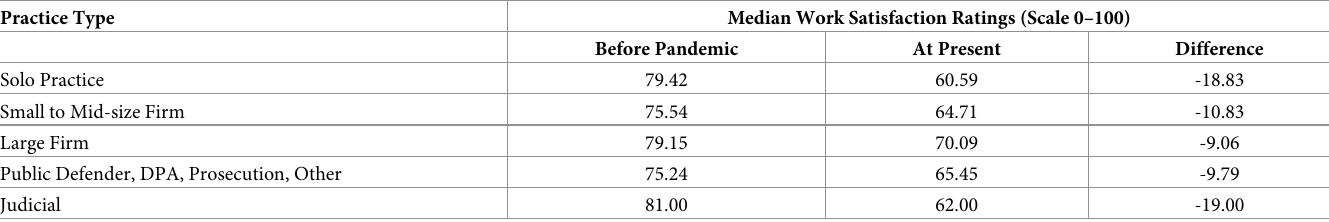
Table 3. Work satisfaction median ratings before pandemic to present by practice